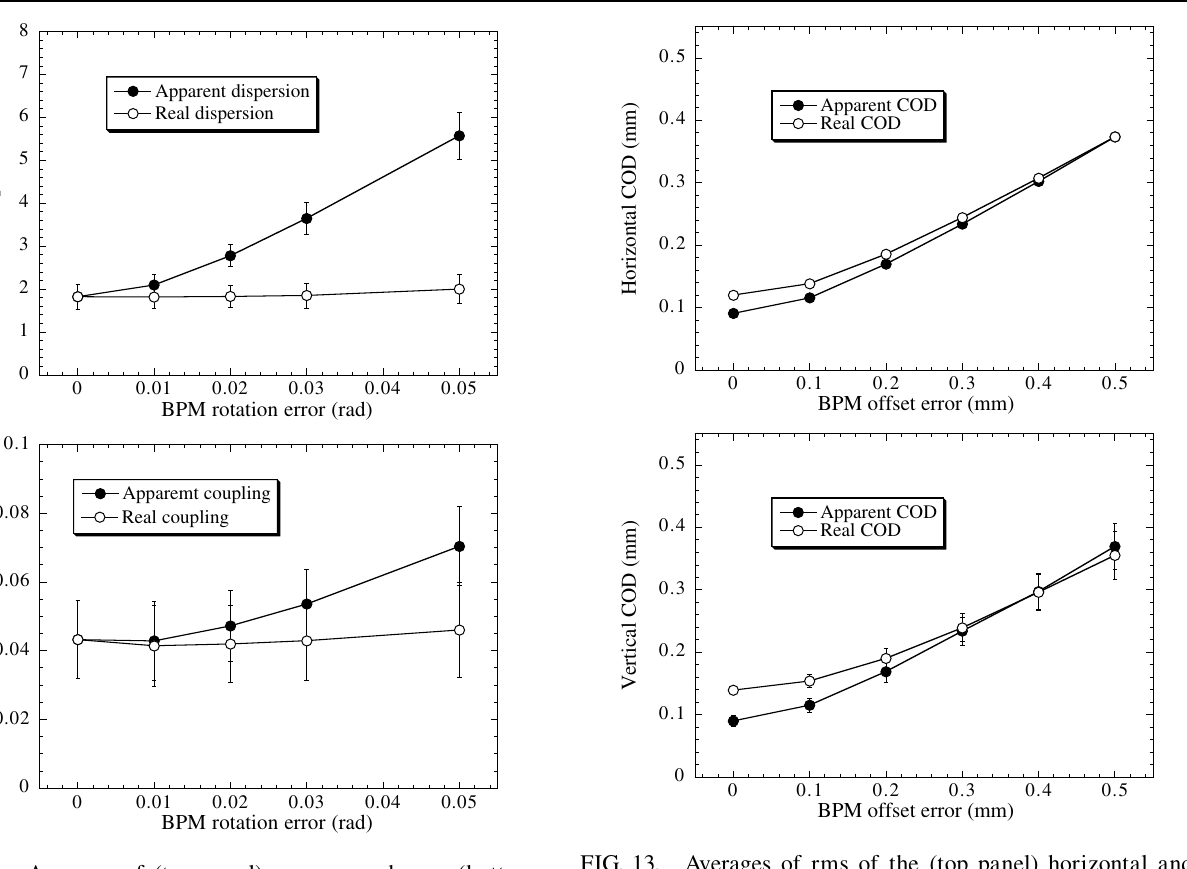
after the coupling correc- a